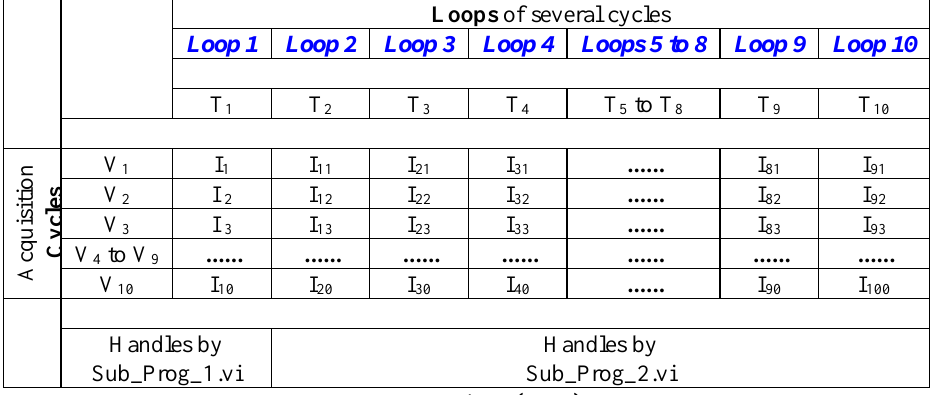
Table 1: an example to show how a .csv data file creates different sets of data of variable-2 (I) against variable-1 (V) at different values of the third variable (T).